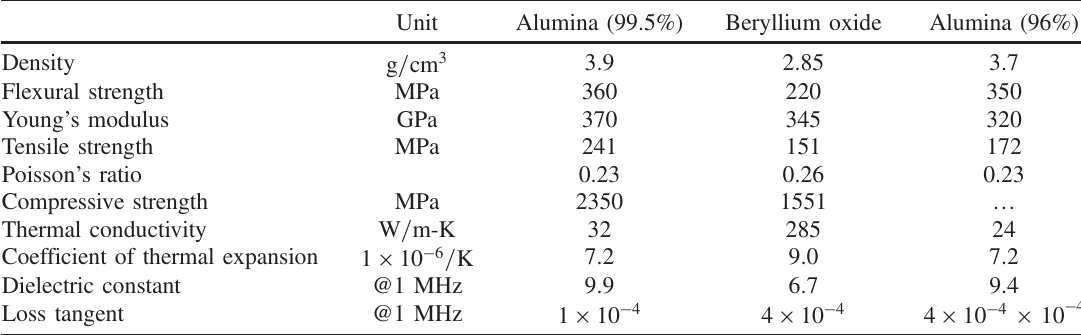
TABLE II. Material property.